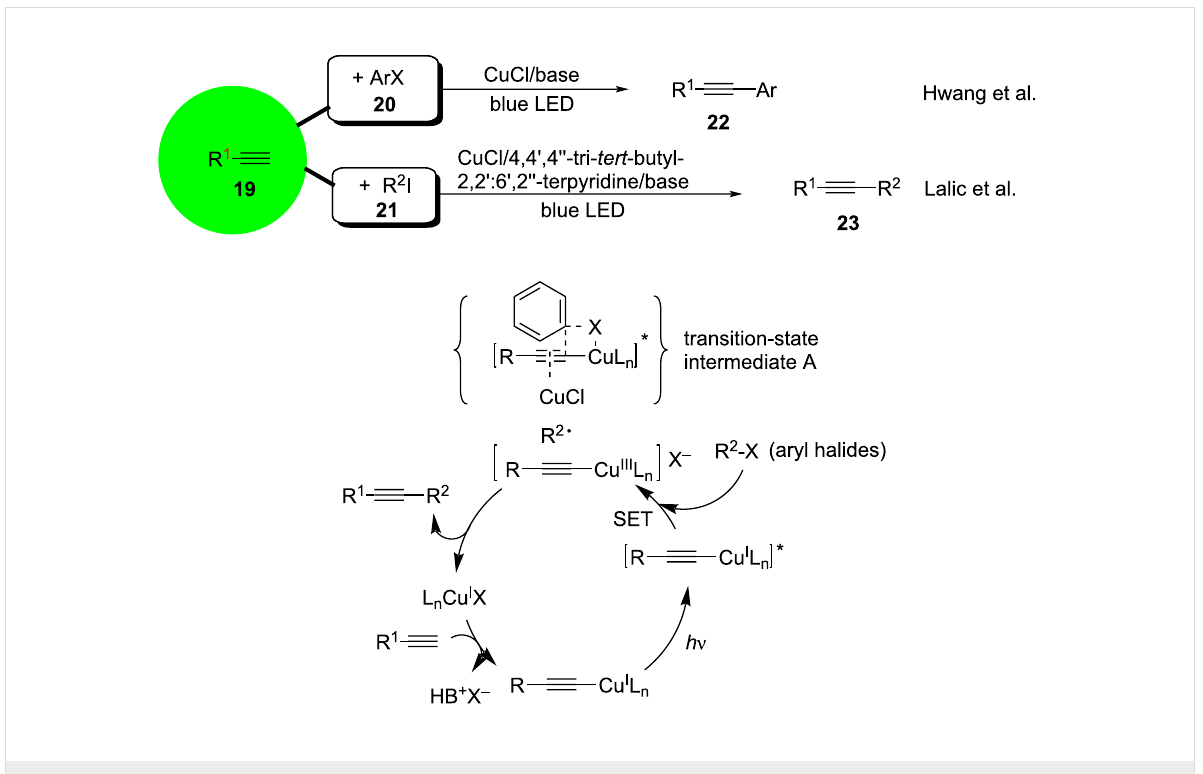
Scheme 15: Photoinitiated copper-catalyzed Sonogashira